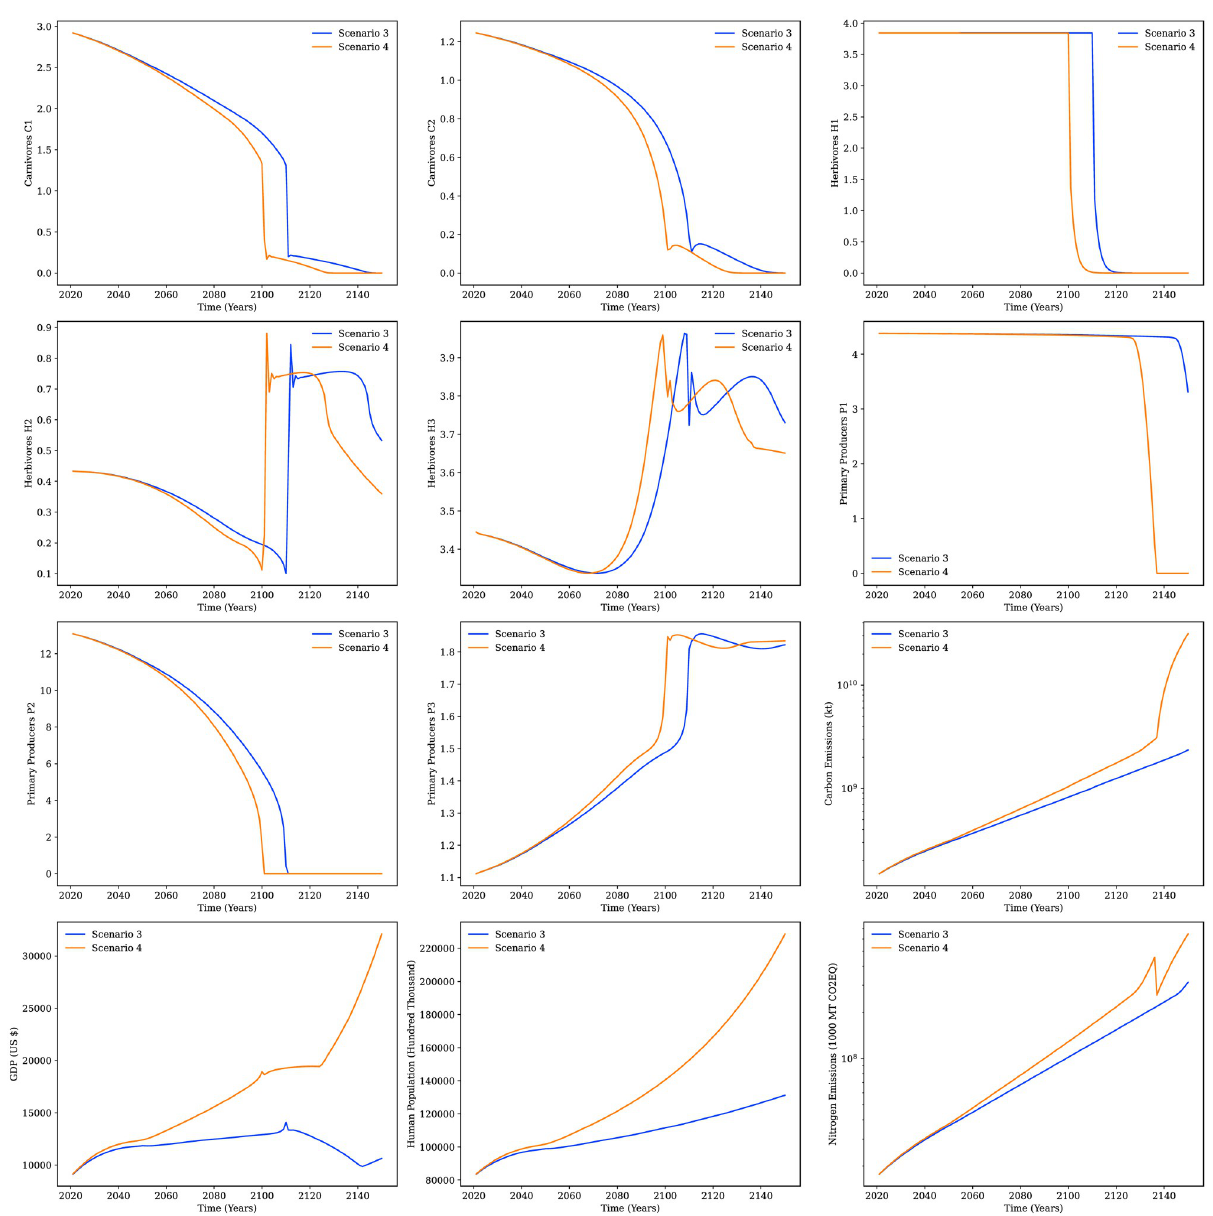
Fig 10. Results for all compartments for the per capita consumption increase scenario (scenario 3) and population explosion with per capita consumption increase scenario (scenario 4).